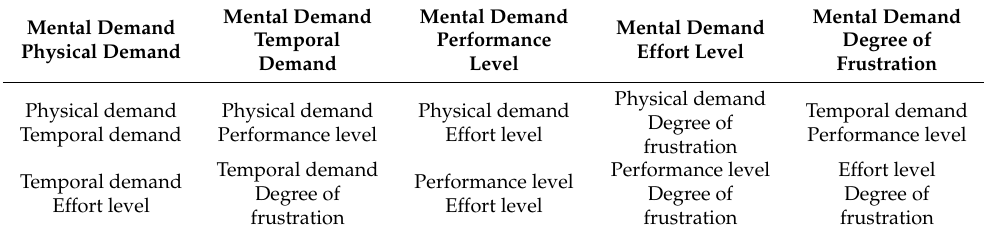
Table 14. NASA-TLX 6-dimensional comparison